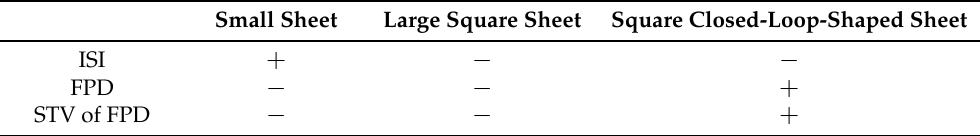
Table 1. Summary of the effect of E-4031 on three geometry of